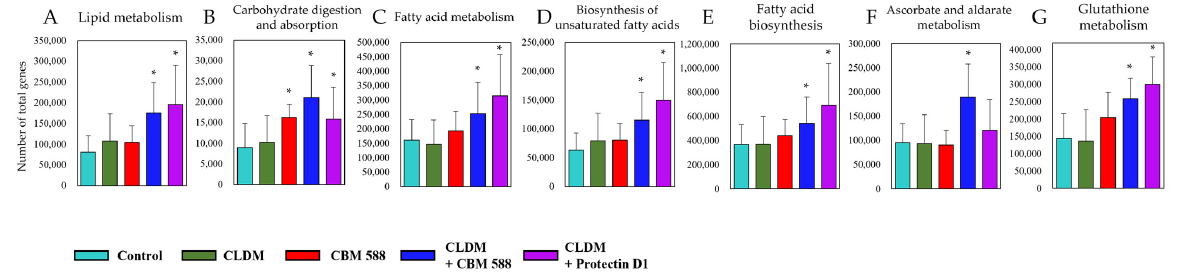
Figure 2. Gut microbiome modified with CBM 588 and protectin D1 enhances functional genes associated with lipid metabolism and antioxidant stress. Number of total genes in each pathway in lipid metabolism ( A ) carbohydrate digestion and absorption ( B ) fatty acid metabolism ( C ) biosynthesis of unsaturated fatty acids ( D ) fatty acid biosynthesis ( E ) ascorbate and aldarate metabolism ( F ) and glutathione metabolism ( G ). Statistical significance was set at p < 0.05. * p < 0.05, compared with control.